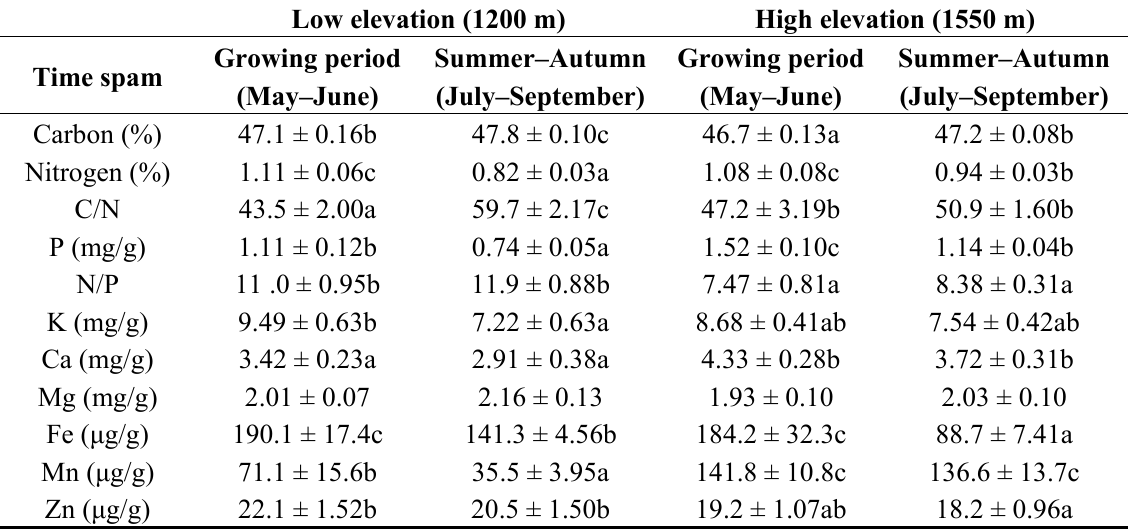
Table 2. Foliar nutrient content measured in two-year-old needles of Abies pinsapo trees along an altitudinal gradient (low elevation, 1200 m; high elevation, 1550 m). Mean values were averaged comparing the early (May-June) and late growing period (July-September); different letters indicate significant differences for repeated measures